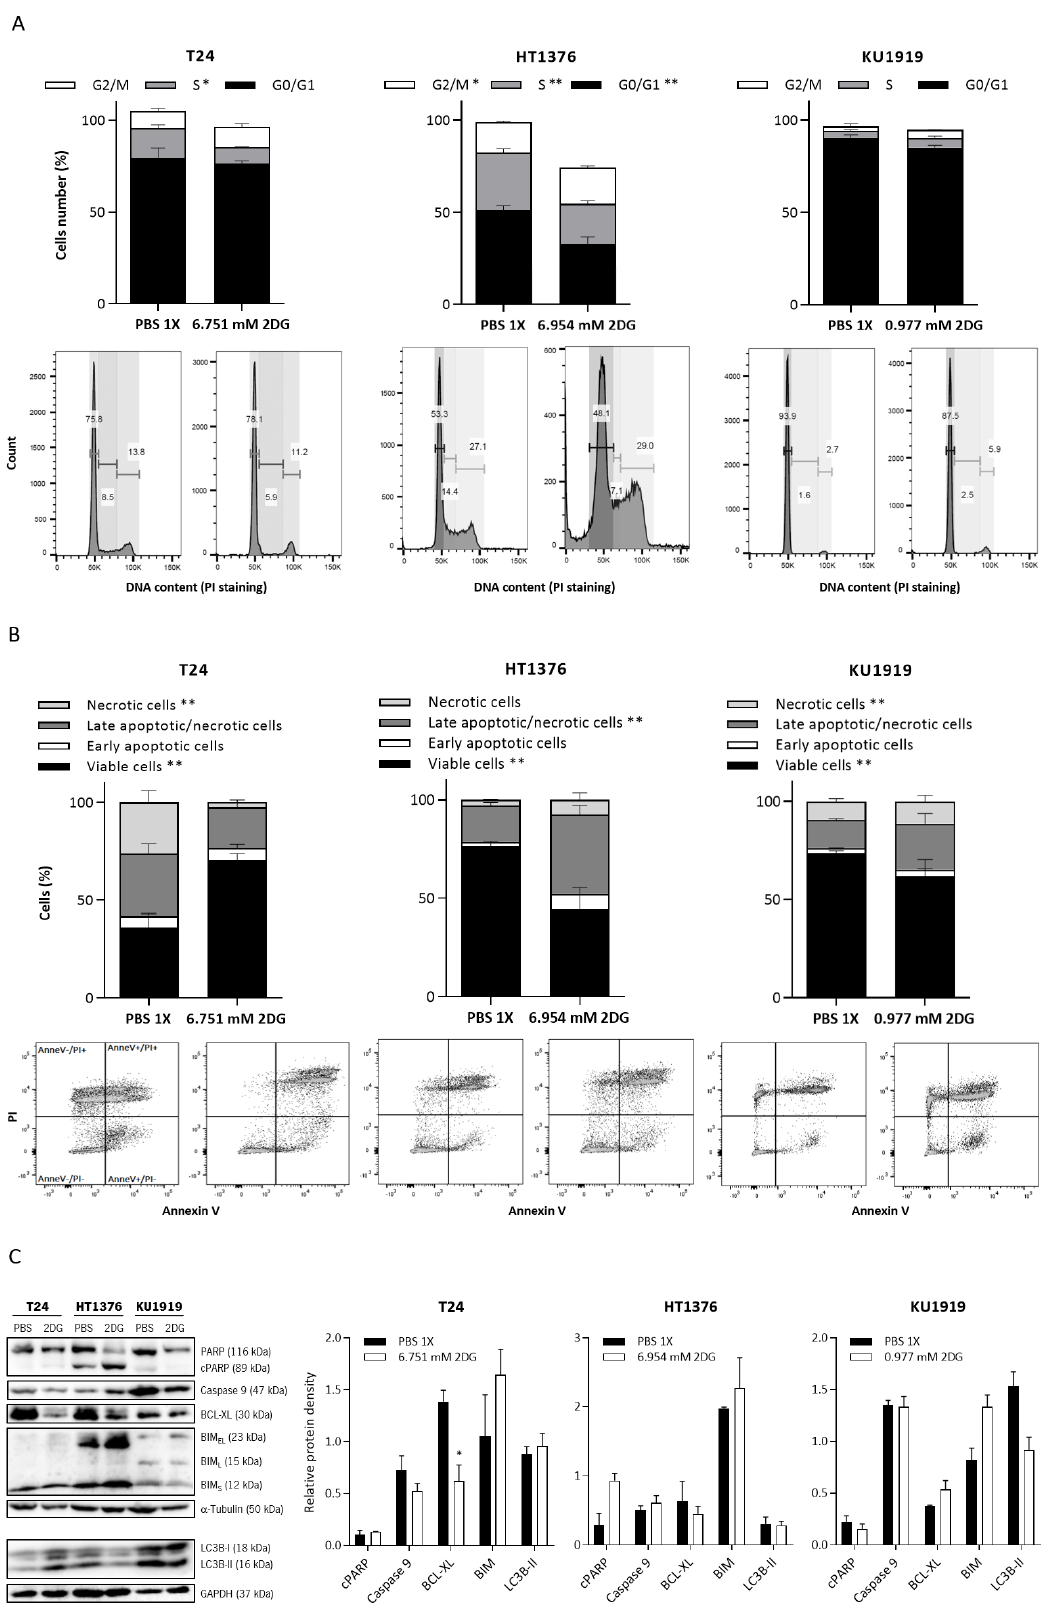
Figure 8. Effect of 2DG on cell cycle ( A ) and cell death ( B, C ) of T24, HT1376, and KU1919 urothelial bladder carcinoma cell lines, detected by flow cytometry analysis of propidium iodide (PI) ( A ) and Annexin V/PI ( B ), and Western blot analysis of proteins associated with cell death pathways at 72 h post-treatment. In ( A ), quantification of the cells in distinct phases of the cell cycle is shown,